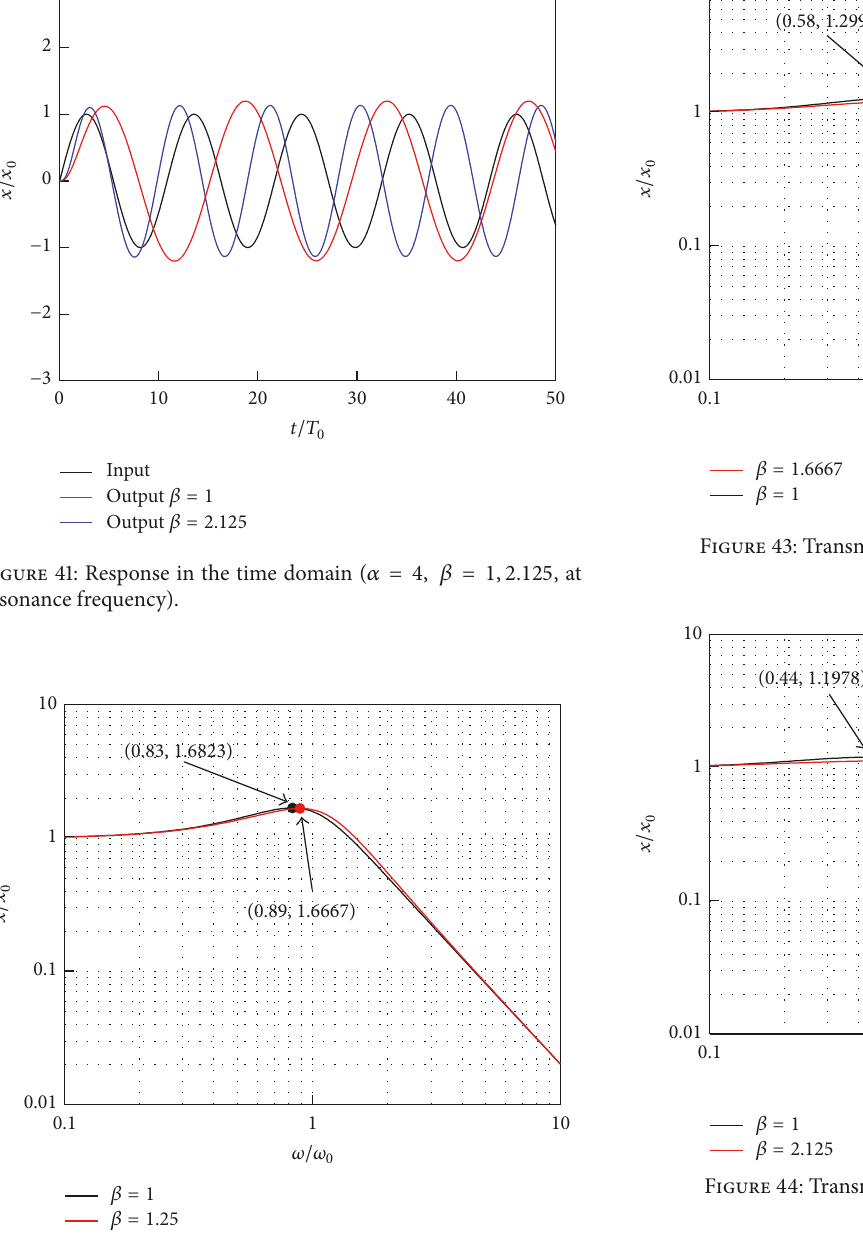
Figure 42: Transmissibility ( 𝛼 = 2, 𝛽 = 1, 1.25 ).